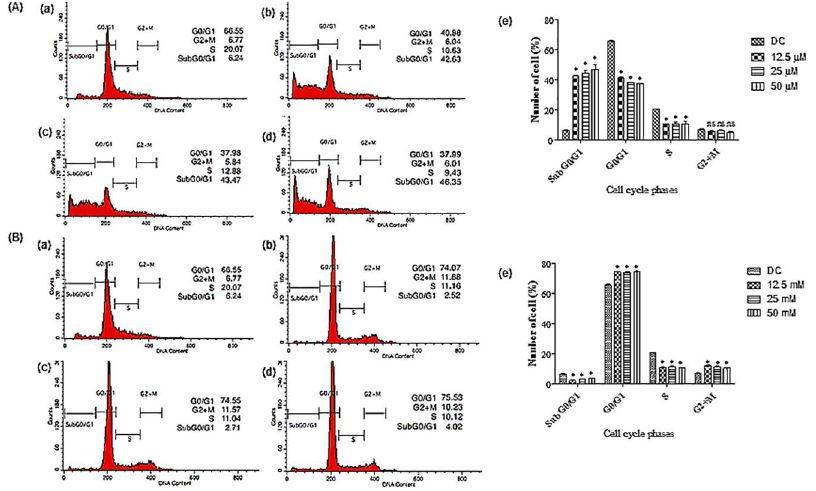
Fig 6. Cell cycle analysis examined using flow cytometry on HT-29 cells after 72 h treatment. (A) Cells treated with (a) DMSO at the final concentration of 0.1%. (b) FKB at a concentration of 12.5 (3.55 μ g/mL), (c) 25 (7.1 μ g/mL), (d) 50 μ M (14.2 μ g/mL), and (e) Percentageof cell cycle distributionin different phases.(B) Cells treated with (a) DMSO at the final concentration of 0.1%. (b) APN at 12.5 (3.37 μ g/mL), (c) 25 (6.75 μ g/ mL), (d) 50 μ M (13.5 μ g/mL) concentrations, and (e) Percentageof cell cycle distributionin different phases. G0/G1, G2+M, and S are cell phases, respectively; subG0/G1 refers to cell death due to DNA fragmentation. Data are expressedas Mean ± SDof three independent experiments, * p < 0.001,ns: non-significant compared to the normal control.